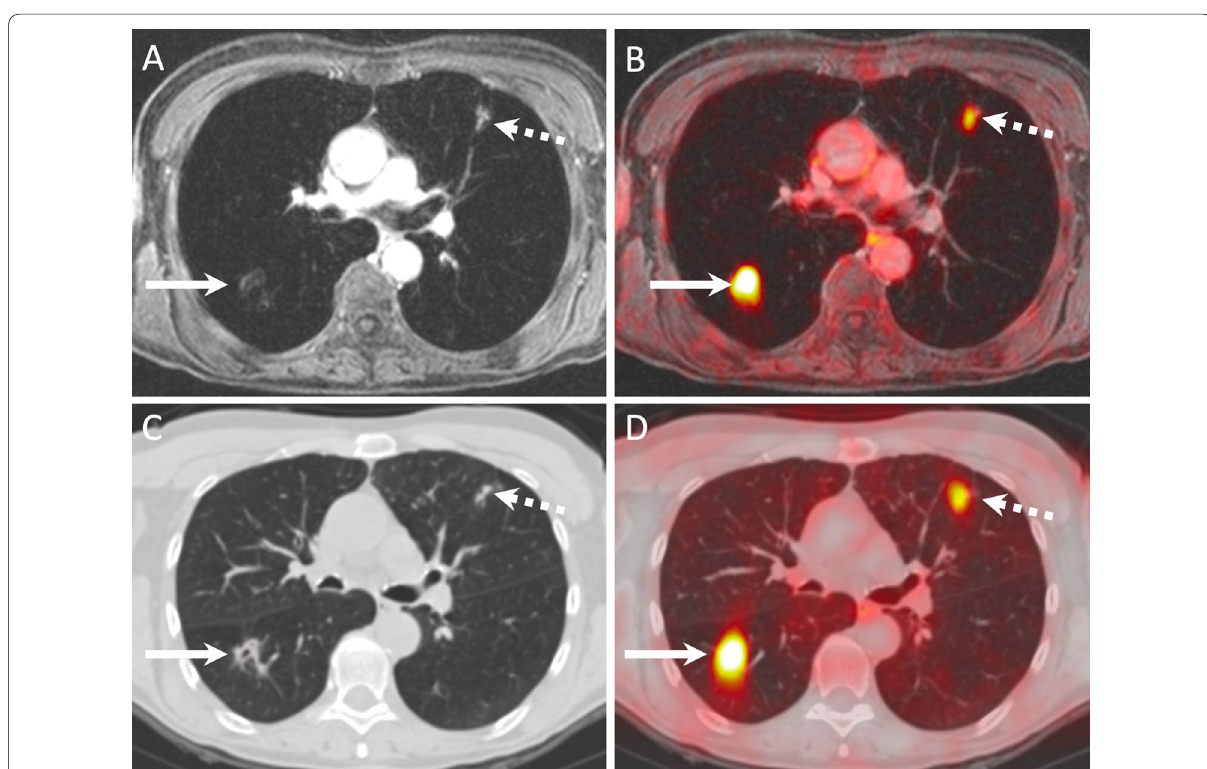
Fig. 3 Lung metastases correctly diagnosed on PET/MRI ( A , B ) and PET/CT ( C , D ) in a 60-year-old female with nodal recurrence after radiochemotherapy for oropharyngeal HPV-negative SCC. The right upper lobe metastasis (arrows) shows a combination of high focal FDG uptake (SUVmax on PET/MRI 7.7 and SUVmax on PET/CT 9.3) and an excavated aspect on the contrast-enhanced fat-saturated MR image and on the = = corresponding CT image. The left upper lobe metastasis (dashed arrows) displays minor focal [ 18 F]FDG uptake (SUVmax on PET/MRI SUVmax on PET/CT 2.1) and clustered nodules on the corresponding morphologic MRI/CT images. Both lesions were rated with a score of 5 on = PET/MRI and